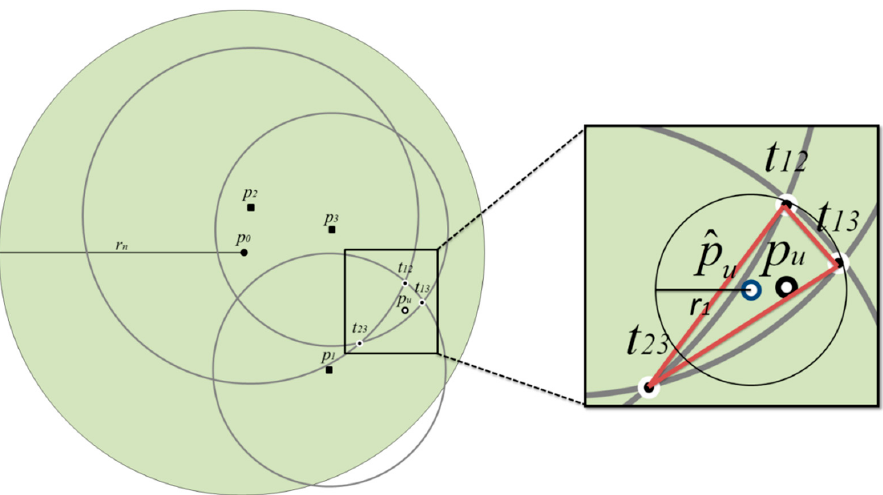
Figure 6. Range-Adjusted Weighted Trilateration.